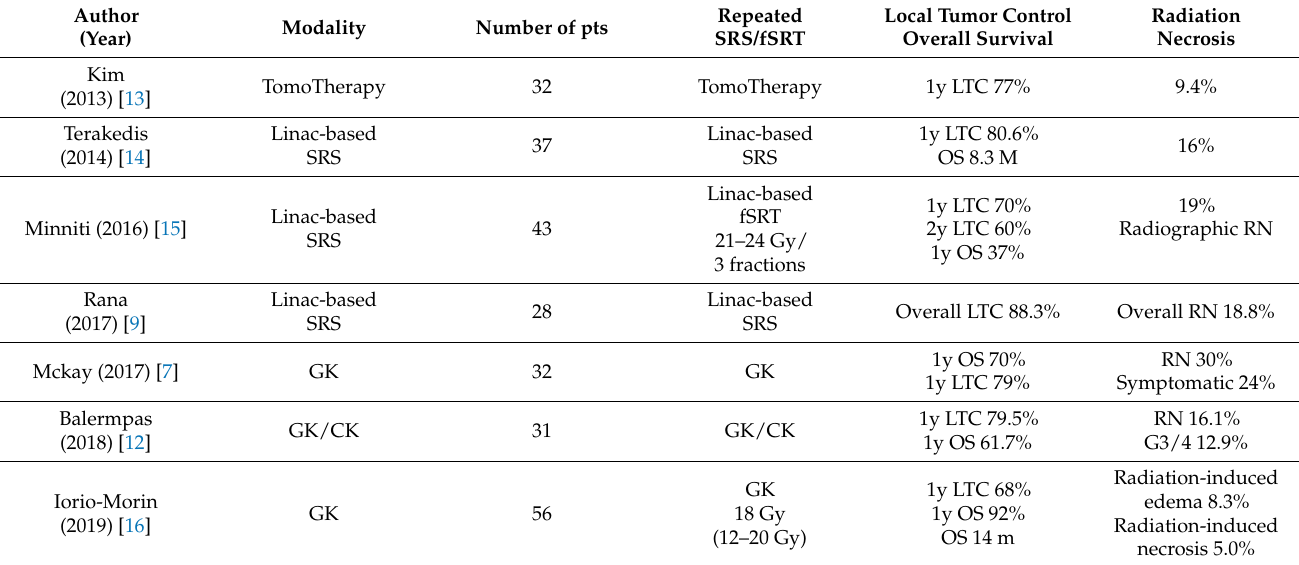
Table 2. Repeated stereotactic radiosurgery for recurrent brain metastasis after stereotactic radiosurgery and fractionated stereotactic